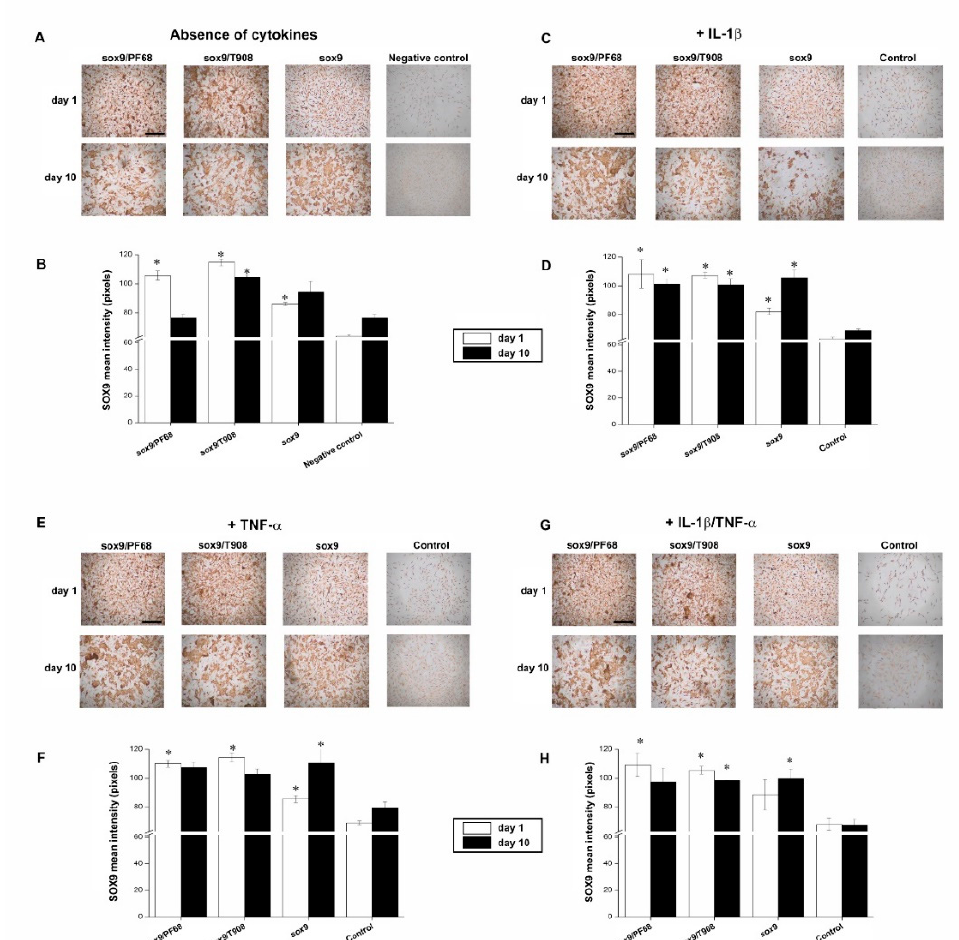
Figure 1. Transgene expression in rAAV-FLAG-h sox9 -transduced human OA chondrocytes using polymeric micelles. Cells in mnolayer culture were directly transduced with the rAAV / polymeric micelles ( A , B ) or after pre-incubation for 4 h with IL-1 β (10 ng / mL) ( C , D ), TNF- α (100 ng / mL) ( E , F ), or IL-1 β / TNF- α (10 / 100 ng / mL) ( G , H ), as described in the Materials and Methods. The cultures were then processed after 1 and 10 days to detect SOX9 expression by immunocytochemistry (magnification x4, scale bar 500 µ m; all representative data) ( A , C , E , G ) with corresponding histomorphometric analyses ( B , D , F , H ), as described in the Materials and Methods. Control conditions included the absence of copolymer or vector treatment (negative control) and the application of free rAAV vector (positive control). * Statistically significant compared with the negative control at similar time points.